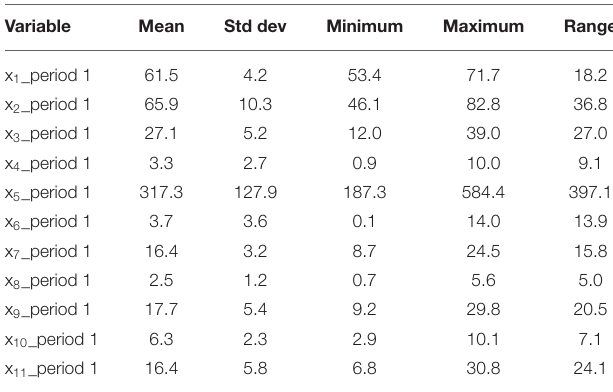
TABLE 1 | Summary statistics of indicators in period 1